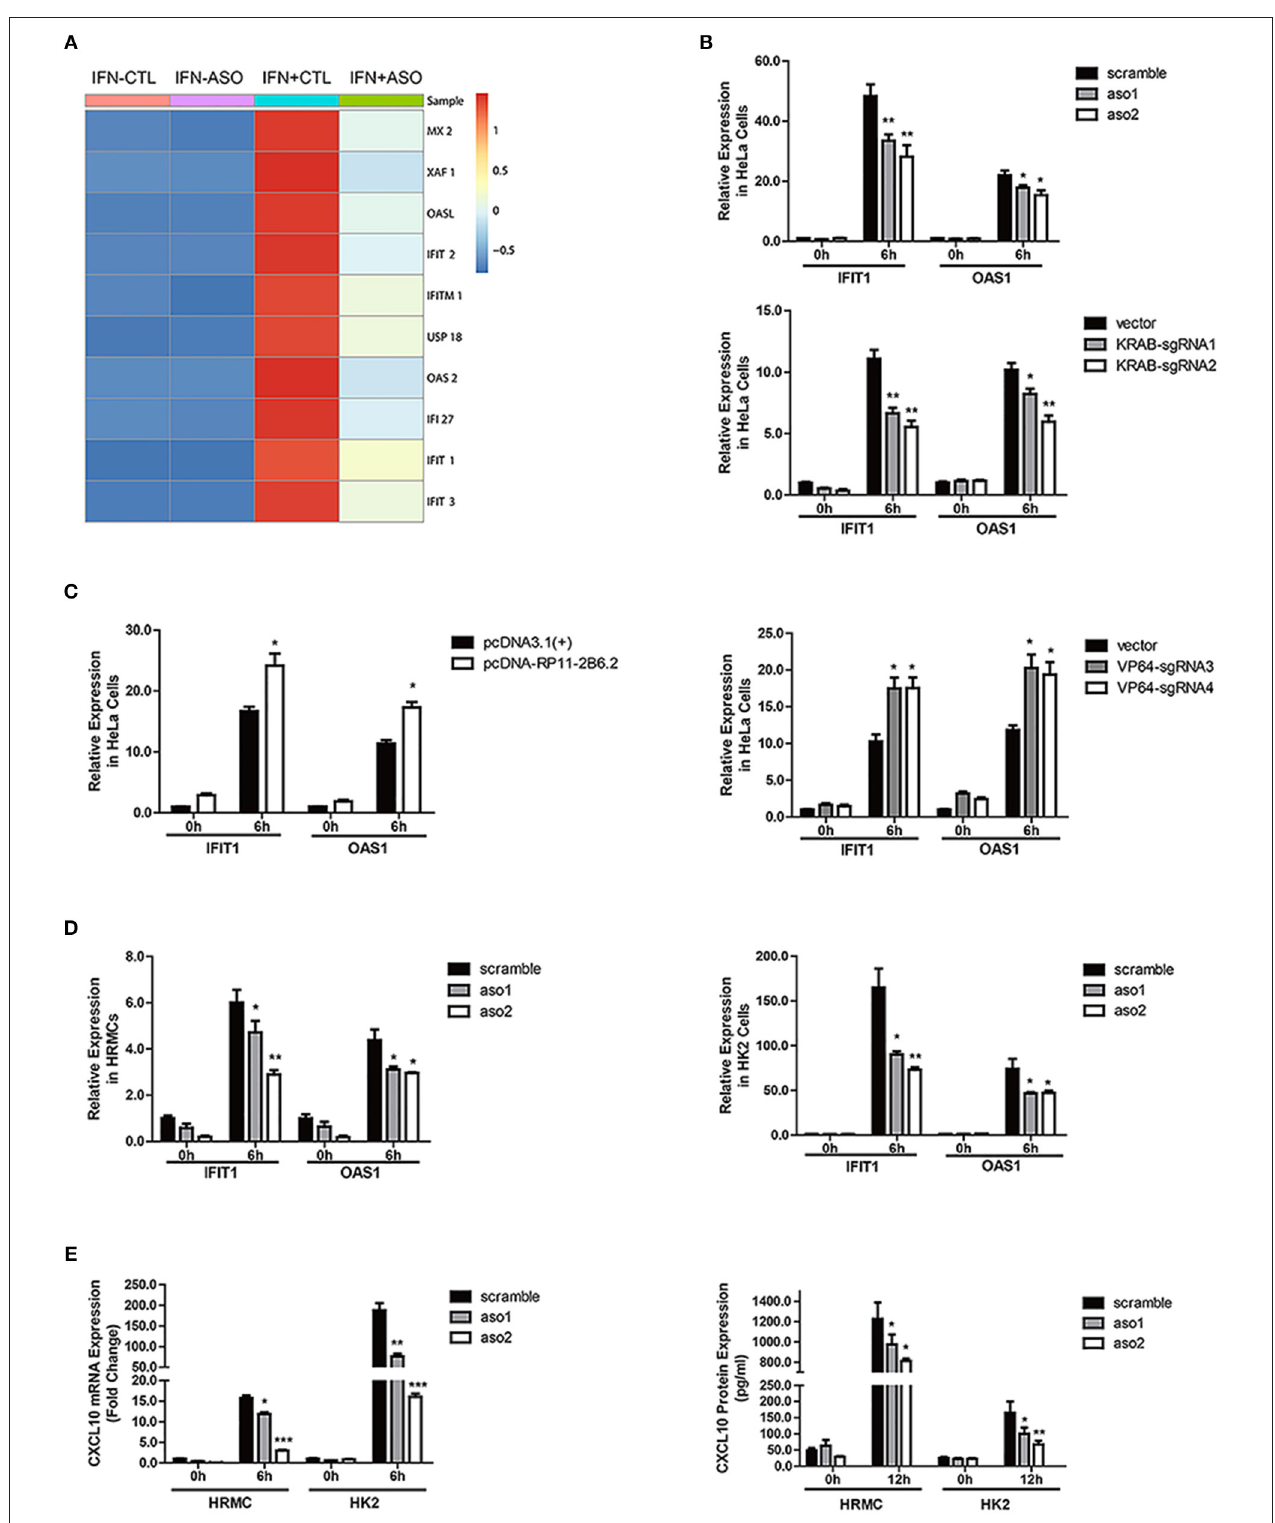
FIGURE 2 | LncRNA RP11-2B6.2 Positively Regulates the Activation of IFN-I Pathway. (A) Expression changes of IFN-I-inducible genes in HeLa cells after down-regulation of lncRNA RP11-2B6.2 by ASOs. (B) HeLa cells were transfected with lncRNA RP11-2B6.2 ASOs (200nM) or scramble (200nM) for 12h,